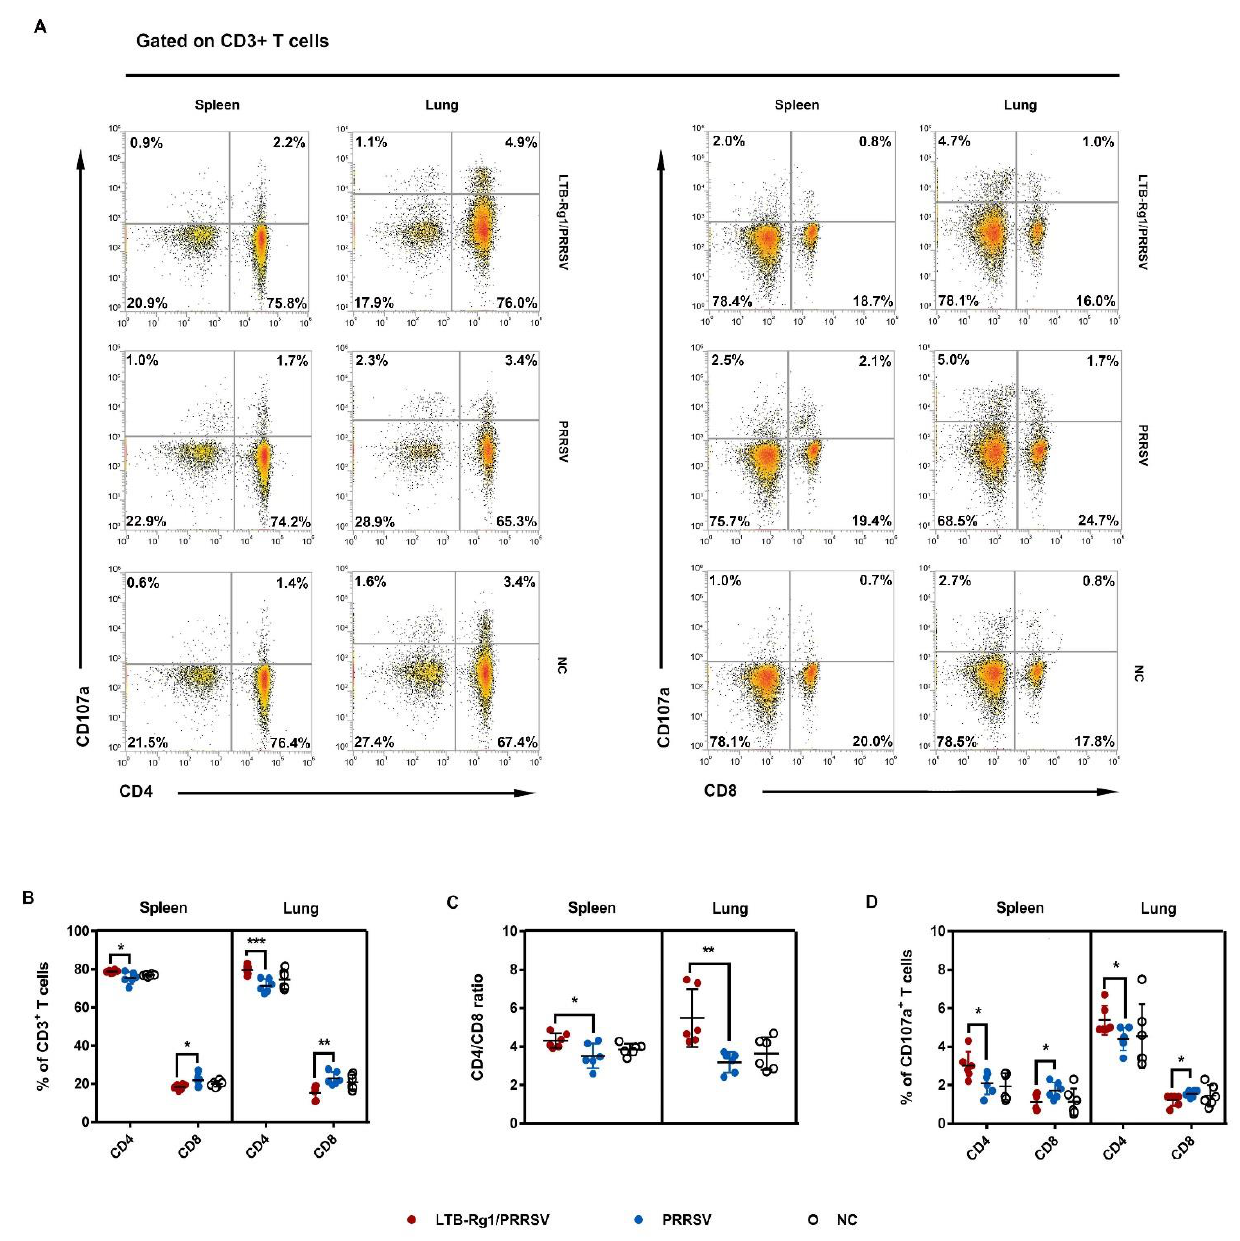
Figure 6. LTB-Rg1 selectively expanded CD4 + T cell proliferation. Mice ( n = 6/group) received PRRSV vaccine without or with LTB-Rg1. Splenocytes and lung mononuclear cells were collected on day 35 post-priming and analyzed by flow cytometry. ( A , B ) CD4 + and CD8 + T cell subpopulations. ( C ) CD4 + /CD8 + ratio. ( D ) CD107a + CD4 + and CD107a + CD8 + T cell percentages. Data are expressed as means ± SD. * p < 0.05, ** p < 0.01, *** p < 0.001.